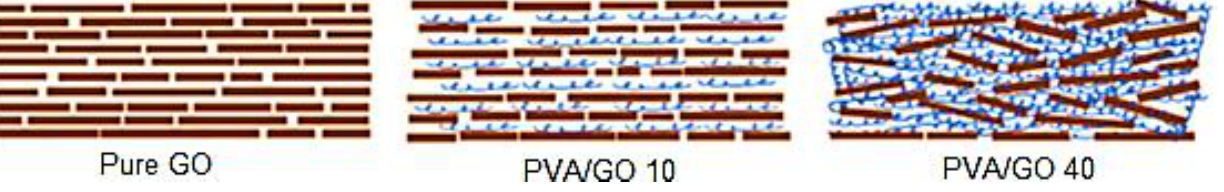
Figure 8. The brick – mortar model of pure GO and PVA/GO intercalated membranes [115]. GO — graphene oxide; PVA/GO — poly (vinyl alcohol)/graphene oxide. Reproduced with permission from reference [115] Copyright 2020 Elsevier.